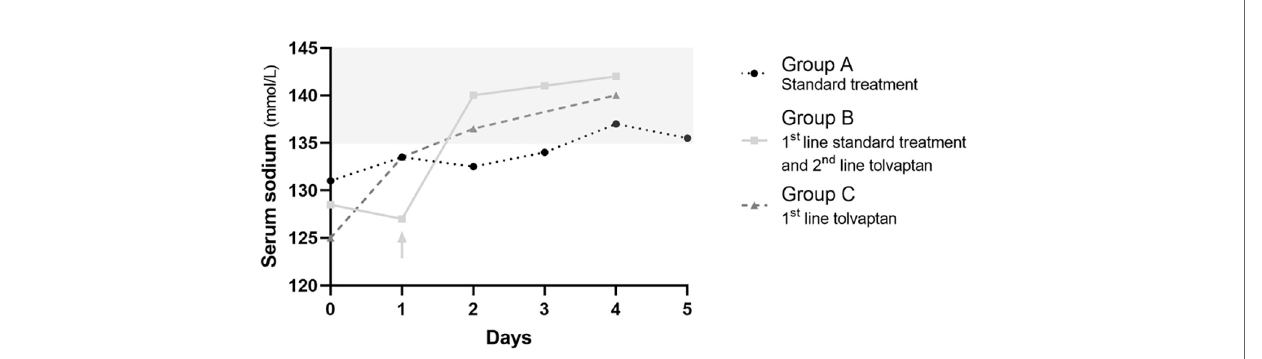
FIGURE 2 | Serum sodium changes overtime in patients receiving standard treatment only (A, black dotted line with circles), fi rst line standard treatment and second line tolvaptan (B, continuous light grey line with squares), and fi rst line tolvaptan (C, dashed dark grey line with triangles). Median values are reported. Day 0 is the day the fi rst line treatment was started. The light grey arrow indicates the switch from standard treatment to tolvaptan in group (B). The light grey area outlines the normal range of serum sodium